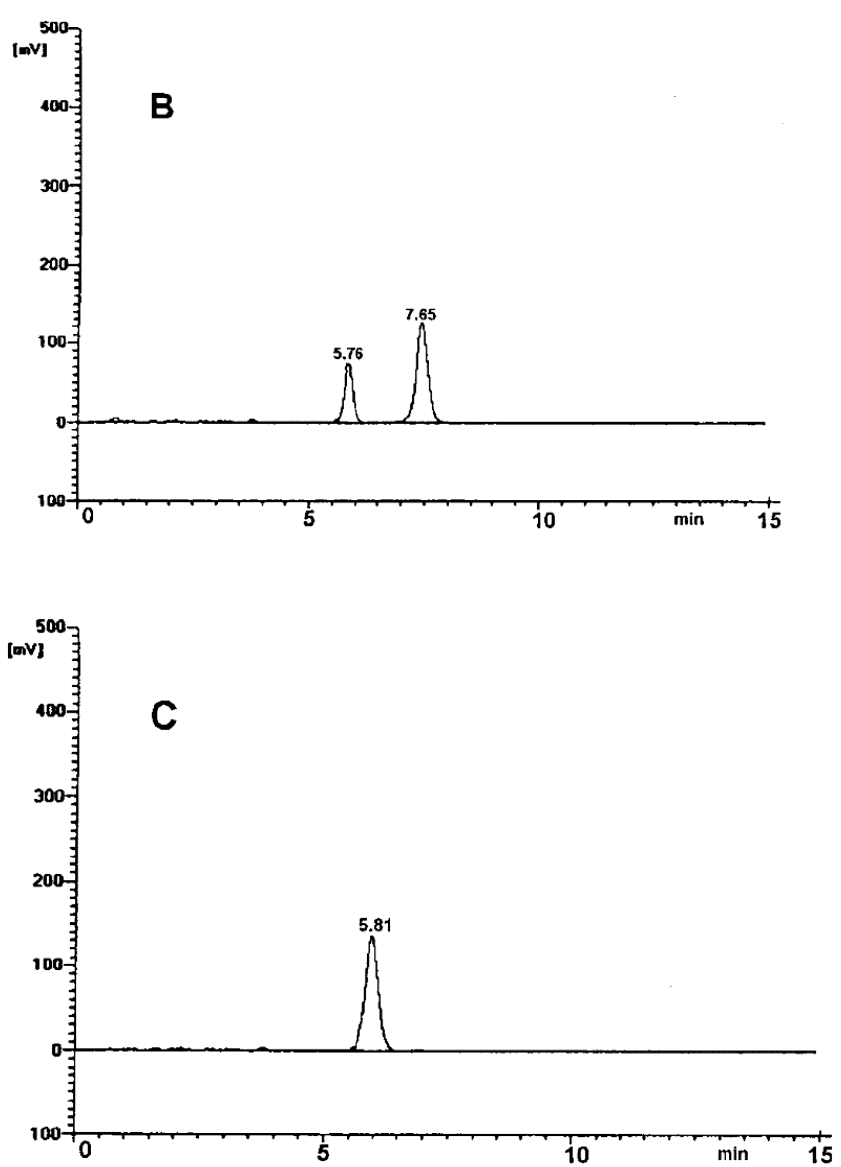
Figure 1. HPLC chromatogram for: ( A ) undegraded RAM in solid state; ( B ) partially-degraded RAM (t = 20 h, 373 K); ( C ) RAM after complete degradation (t = 90 h, 373 K).